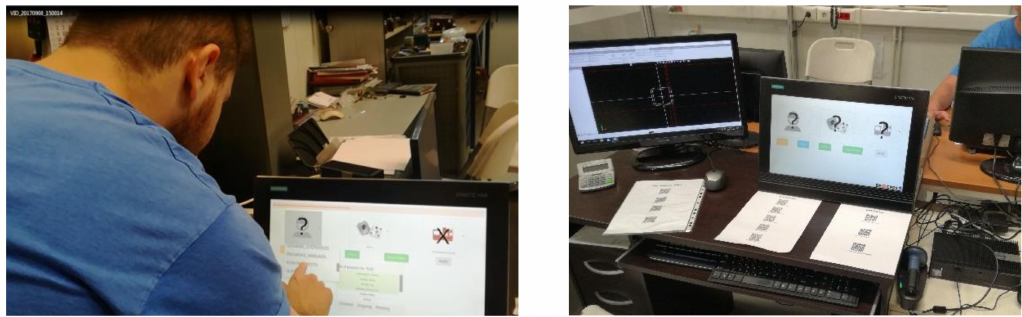
Figure 7. Installation of HW/SW on the shopfloor during the